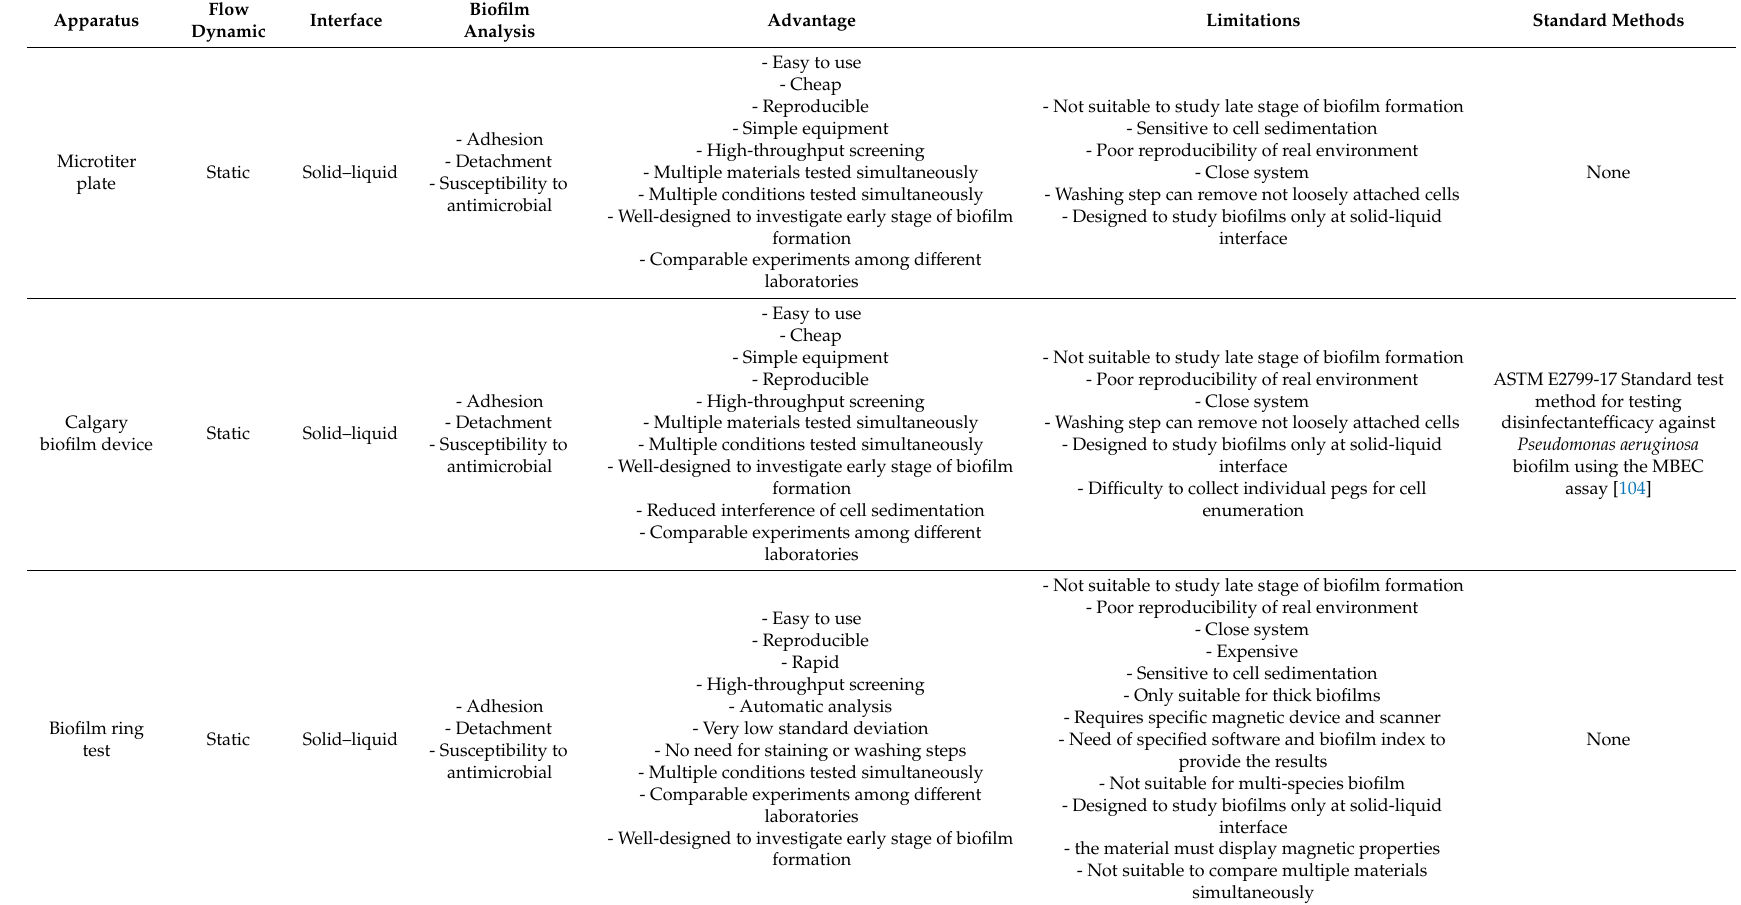
Table 1. Technical information of the most popular laboratory devices used to study anti-biofilm polymeric